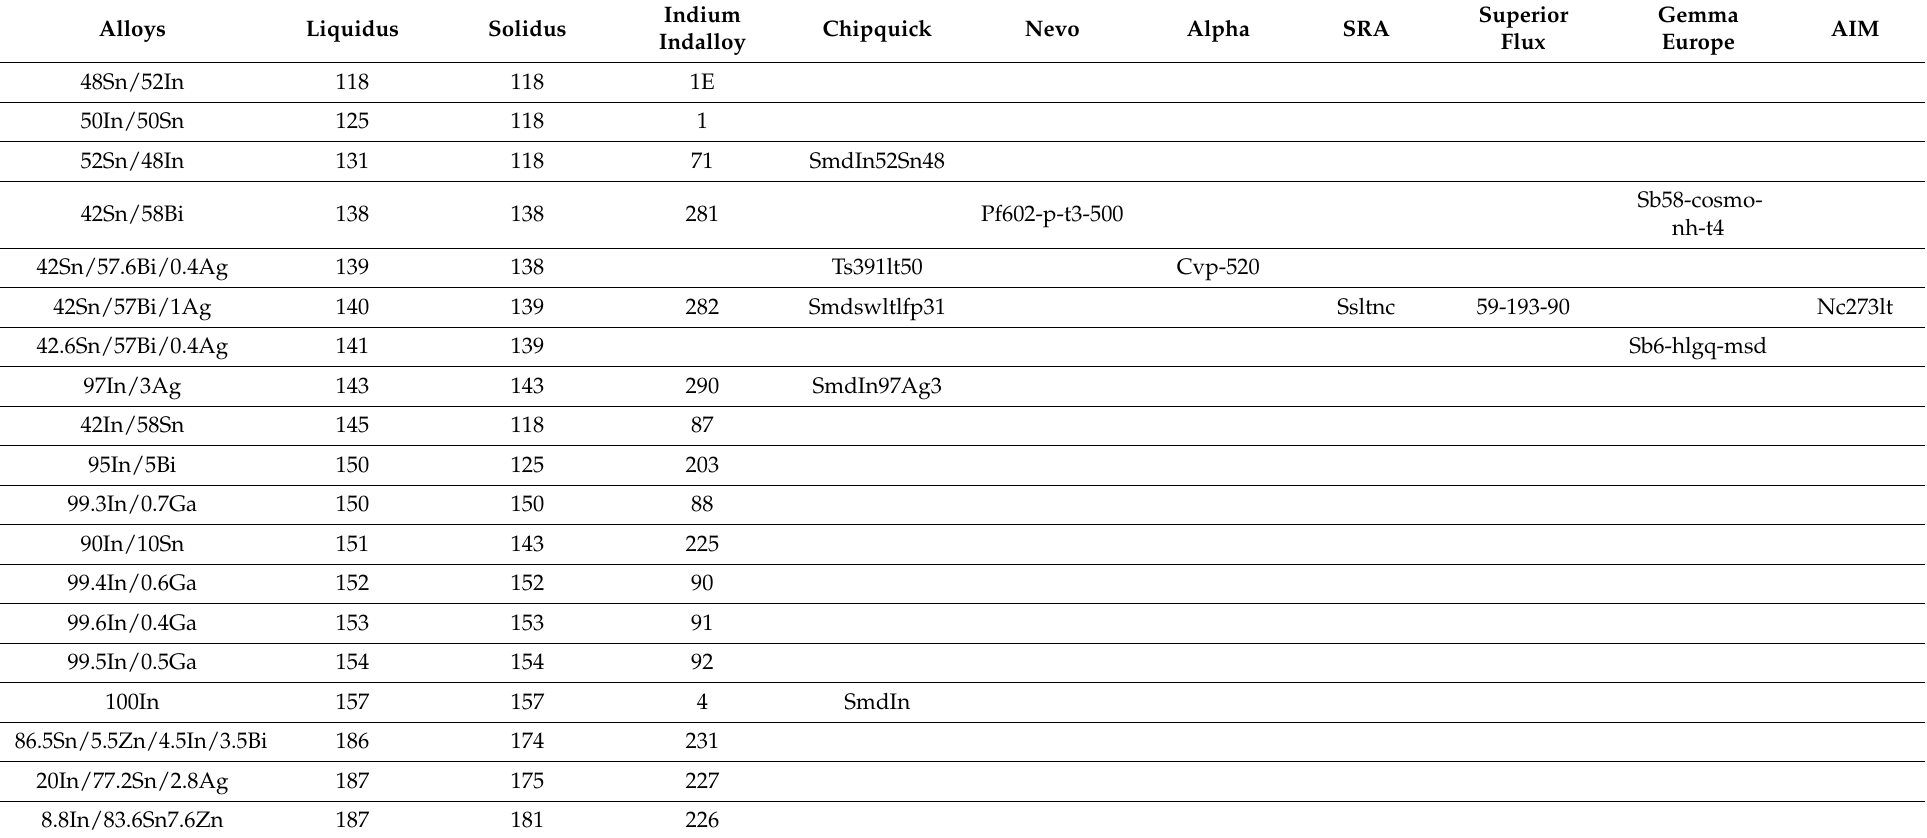
Table A1. Commercial low-temperature solder